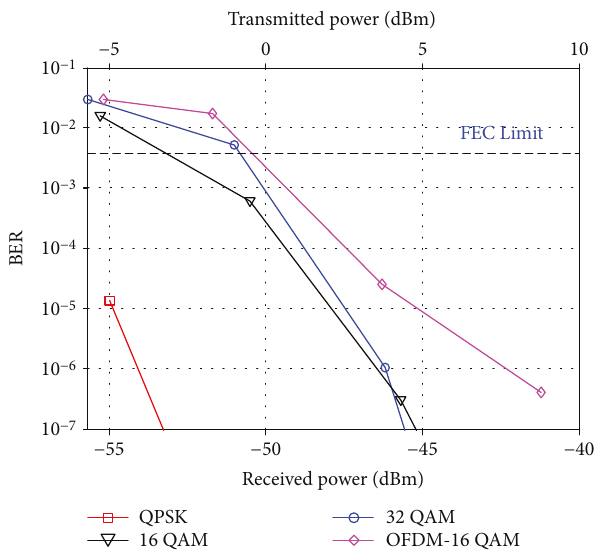
Figure 17: BER versus electrical received power for QPSK, 16QAM, 32QAM, and OFDM-16QAM at 1.5m wireless distance.